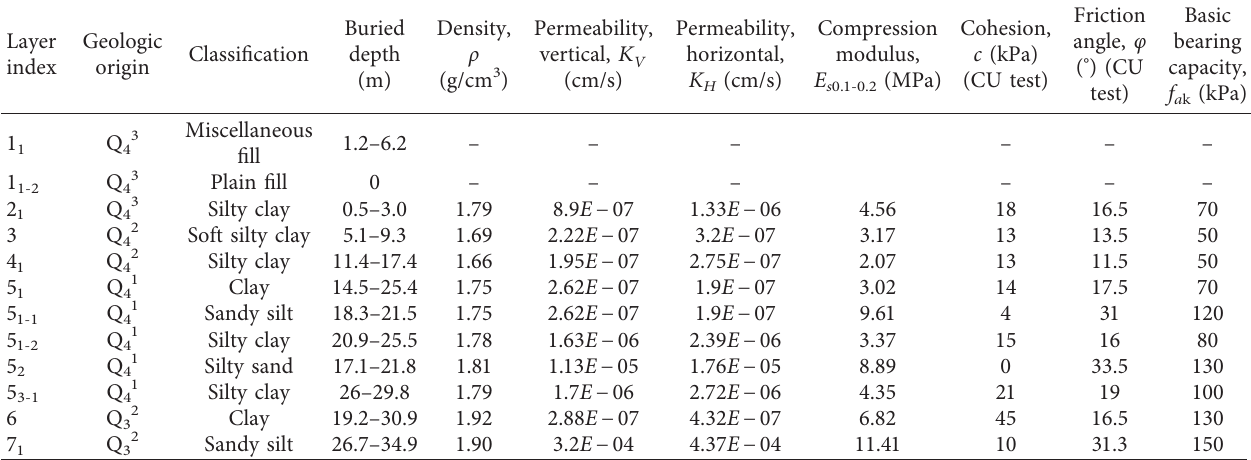
Table 1: Soil parameters of the construction